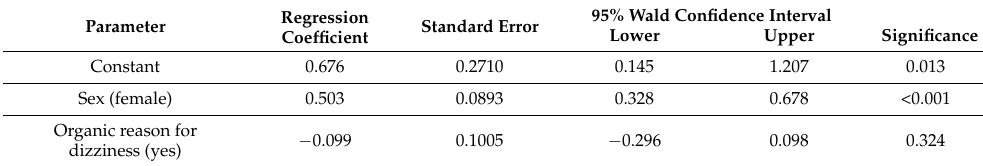
Table 5. Generalized Estimating Equations on Mobility Inventory for Agoraphobia at Follow-Up.